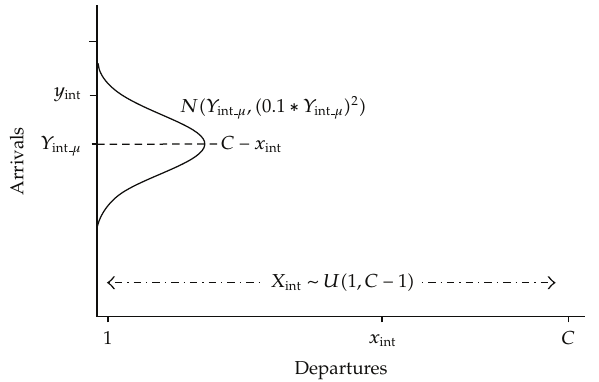
Figure 8: Step 1: the x and y intercepts (cid:2) x int ,y int (cid:3) are